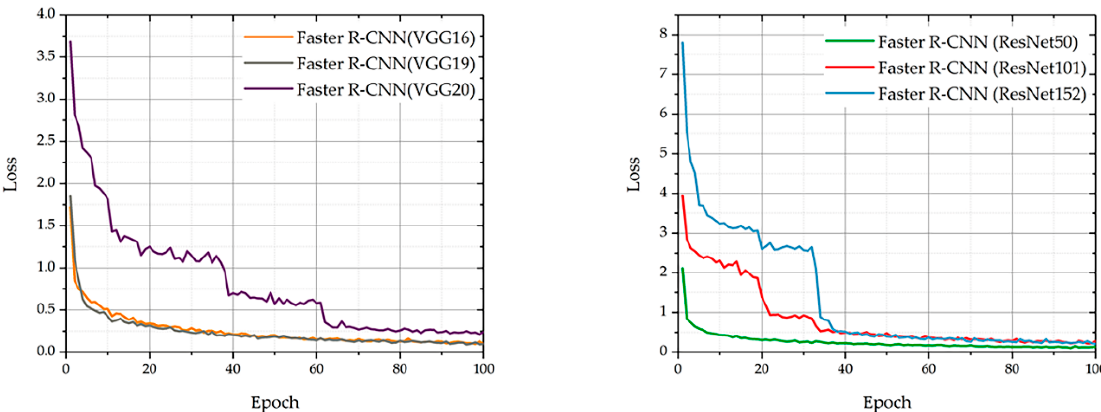
Figure 8. The loss curve with different neural networks as feature map extraction in faster region-based convolutional neural network (Faster R-CNN).